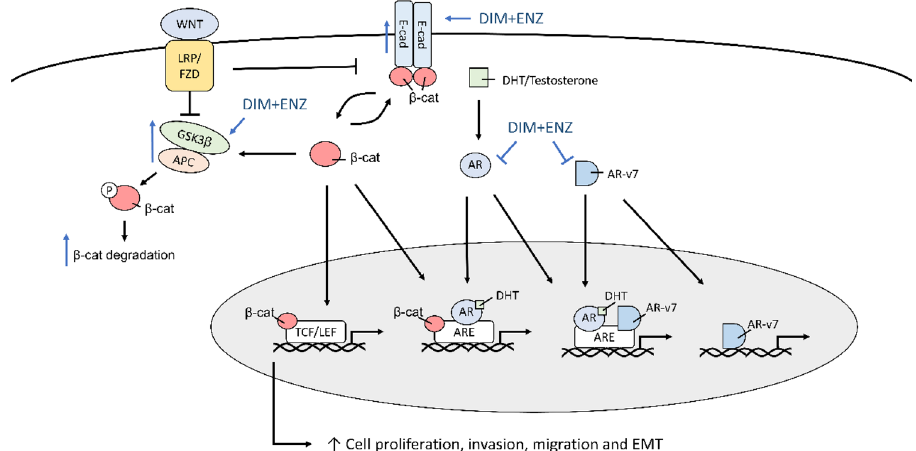
Figure 13. Co-treatment with DIM and ENZ regulates Wnt and AR signaling. AR androgen receptor, ARE androgen receptor element, DHT dihydrotestosterone, APC adenomatous polyposis coli protein, GSK3 glycogen synthase kinase-3, TCF/LEF T-cell factor/lymphoid enhancer factor transcription